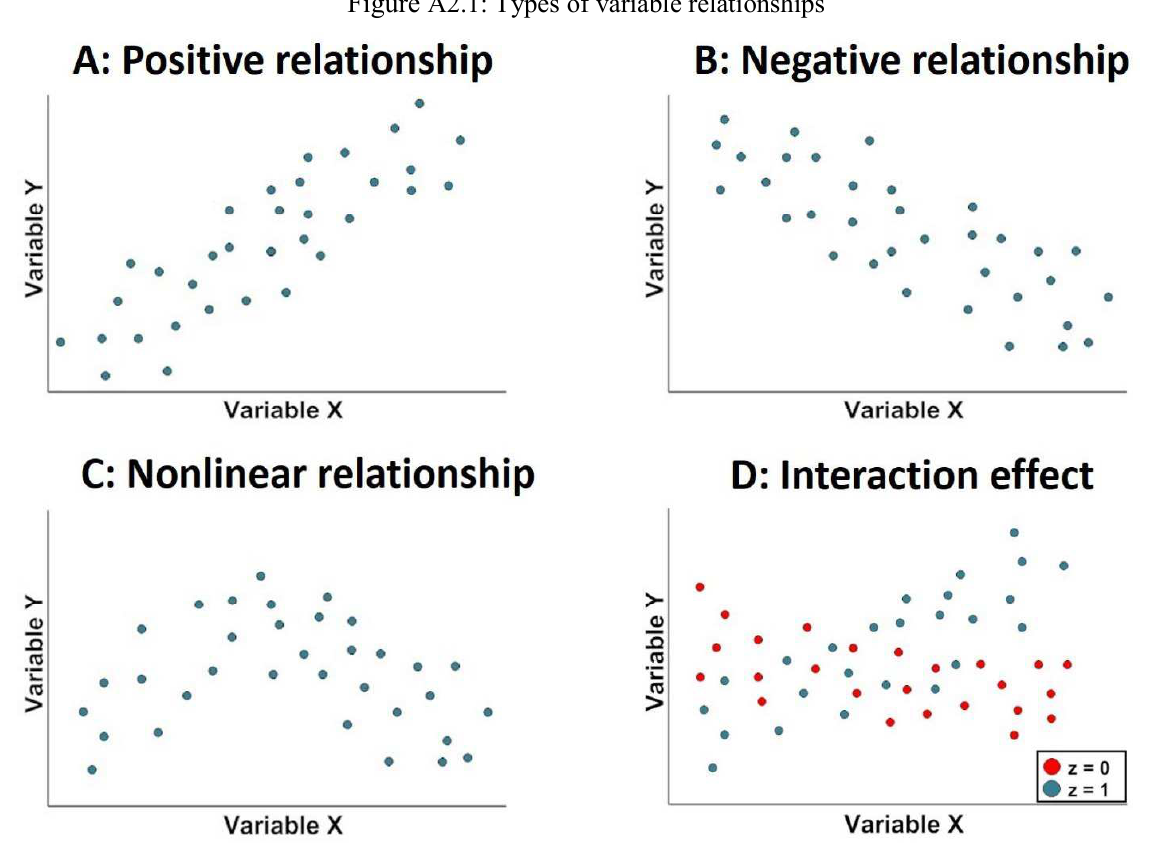
Figure A2.1: Types of variable